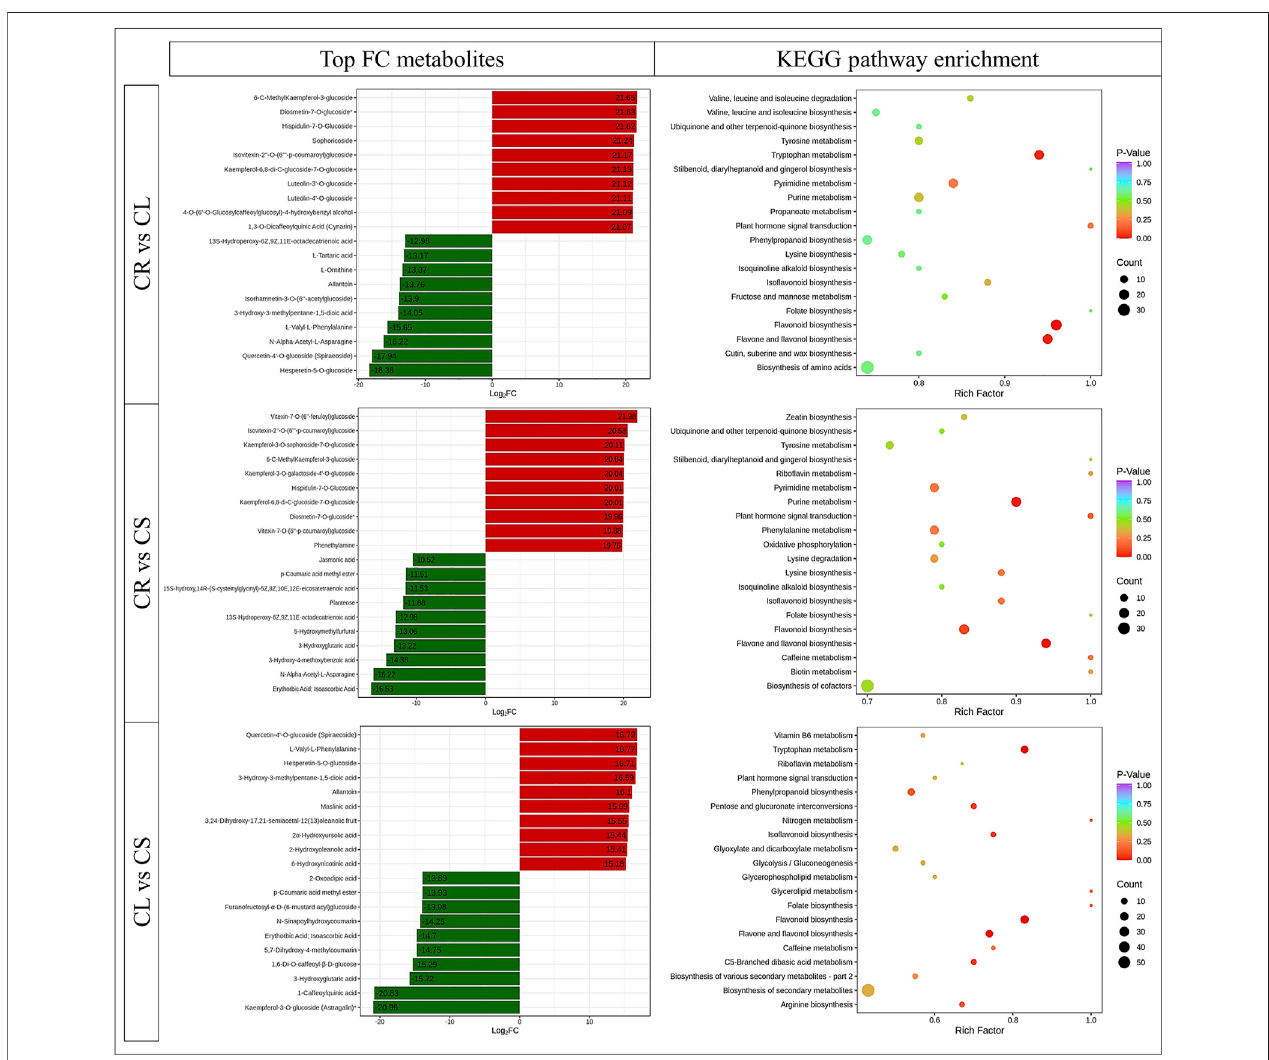
FIGURE2| Top-accumulatedmetabolitesindifferent C.convolvulacea tissues(CL,leaf;CS,stem;CR,tuber)andKEGGscatterplotsshowingpathwaystowhich the DAMs were enriched.